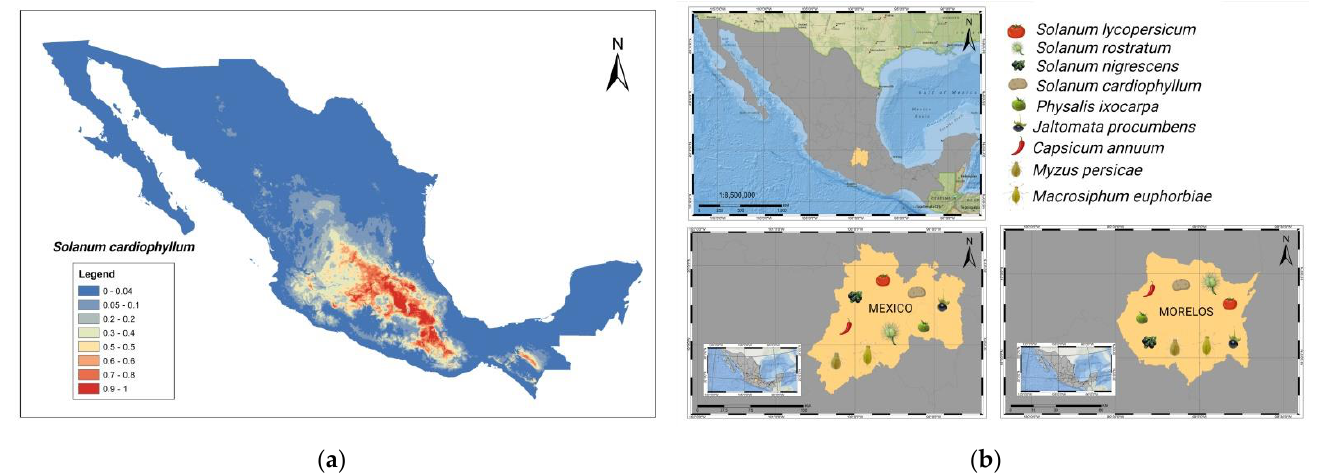
Figure 5. ( a ) Mexico ’ s central region shows the greatest distribution values according to the maxi- mum entropy modeling (Maxent) for Solanum cardiophylum species, an endemic wild reservoir of viroids. ( b ) A remarkable distribution of the insects and the Solanaceae natural hosts are found in Mexico and Morelos